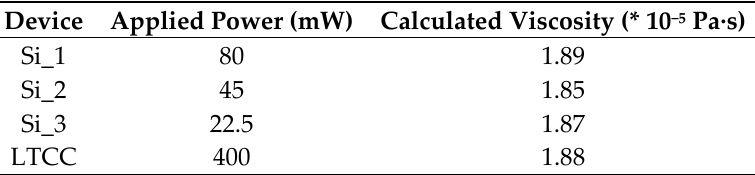
Figure 2. Simulated differential pressure curve once the heater is off. Table 2. Summary of Sensors performance, Gas: Nitrogen.